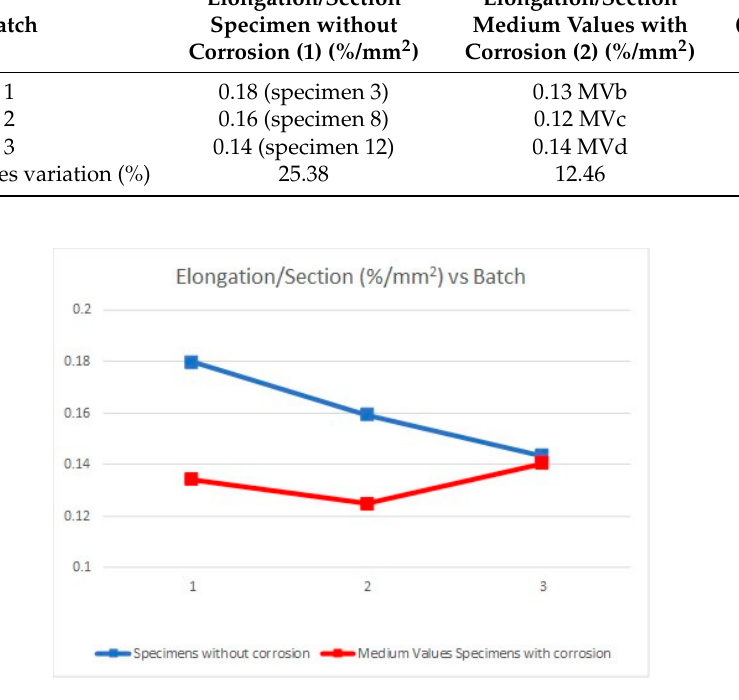
Figure 12. Elongation/Section vs. Batch.